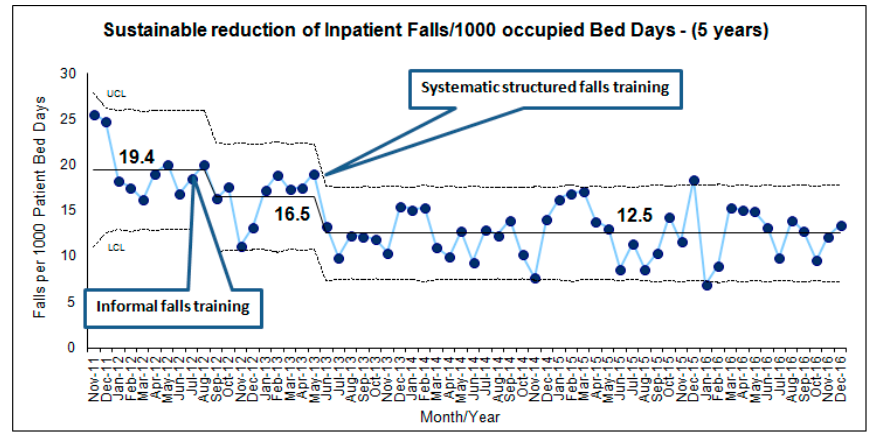
Figure 1. Statistical process U-control chart displaying sustainable reduction of the incidents of inpatient falls in a time sequence over 5 years.